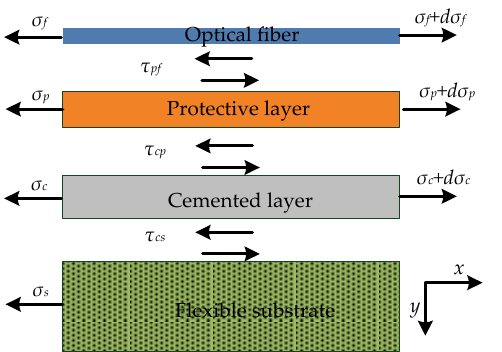
Figure 8. Schematic diagram of grooved-bonded strain-transfer model: ( a ) front view; ( b ) side view. The strain-transfer model between the layers is shown in Figure 9. It is stipulated that E , G , τ , σ , ε , and u represent the elastic modulus, shear modulus, shear stress, axial stress, strain, and displacement, respectively; the subscripts p , f , c , and s represent the protective layer, optical fiber, cemented layer, and flexible substrate, respectively. The coordinate protective layer, cemented layer, and flexible substrate.